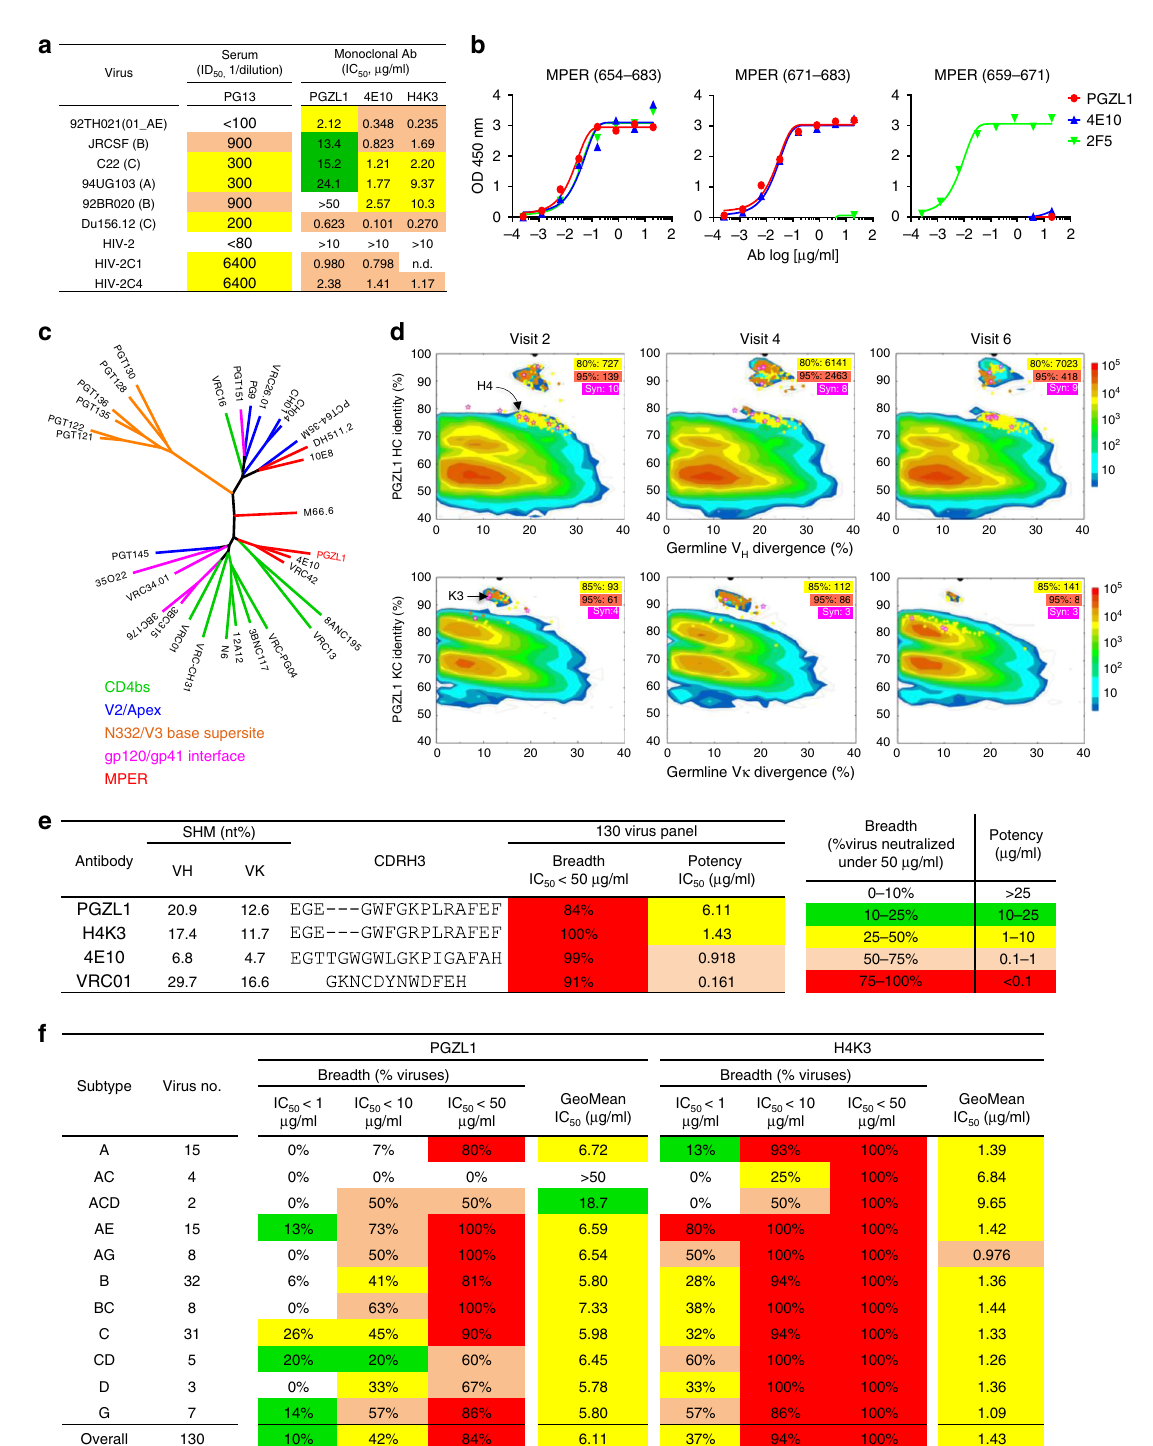
NATURE COMMUNICATIONS| (2019) 10:5389